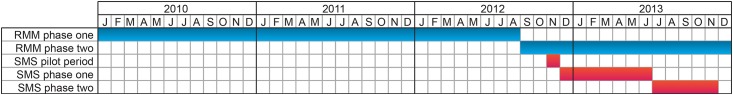
SMS timeline.Timeline of RMM project and SMS implementation from January 2010 through December 2013.